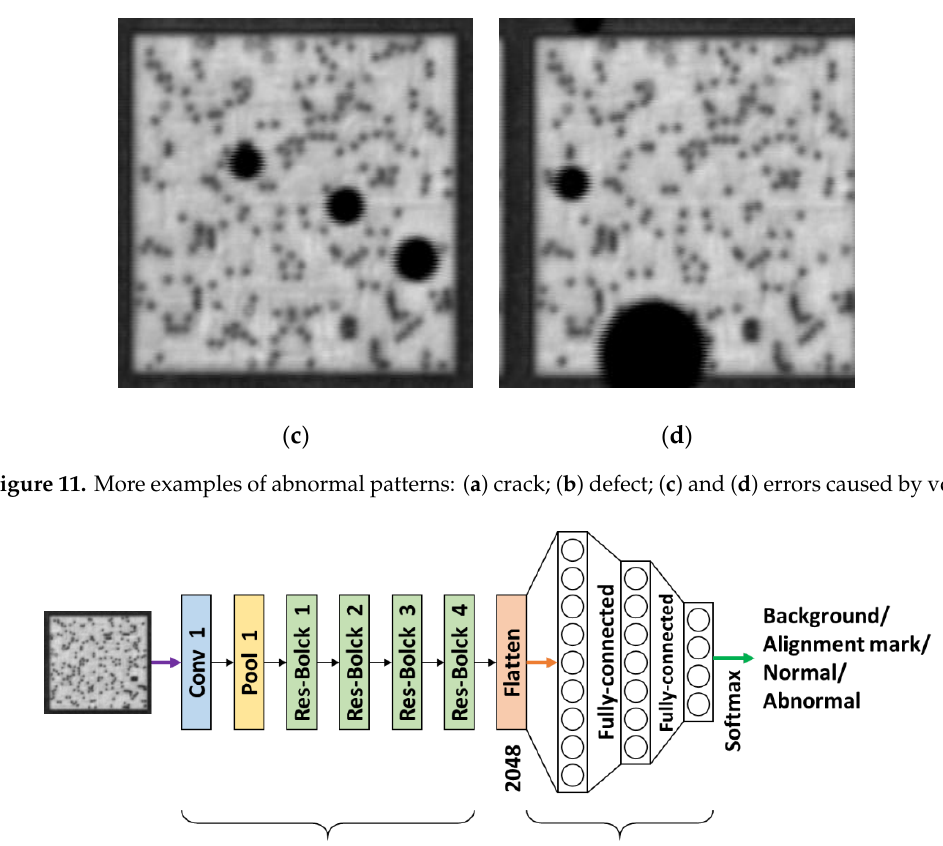
Figure 11. More examples of abnormal patterns: ( a ) crack; ( b ) defect; ( c ) and ( d ) errors caused by voids.